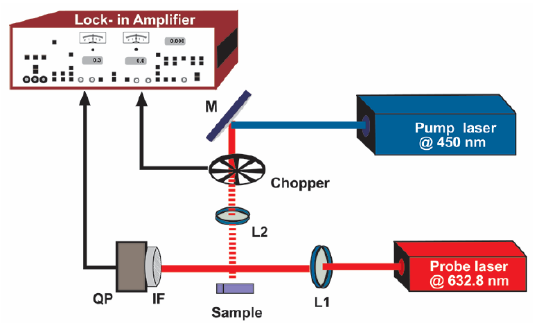
Figure 1. Schematic of the BDS experimental setup. L1, L2: lenses; M: turning mirror; IF: interference filter; QP: quadrant photodiode.